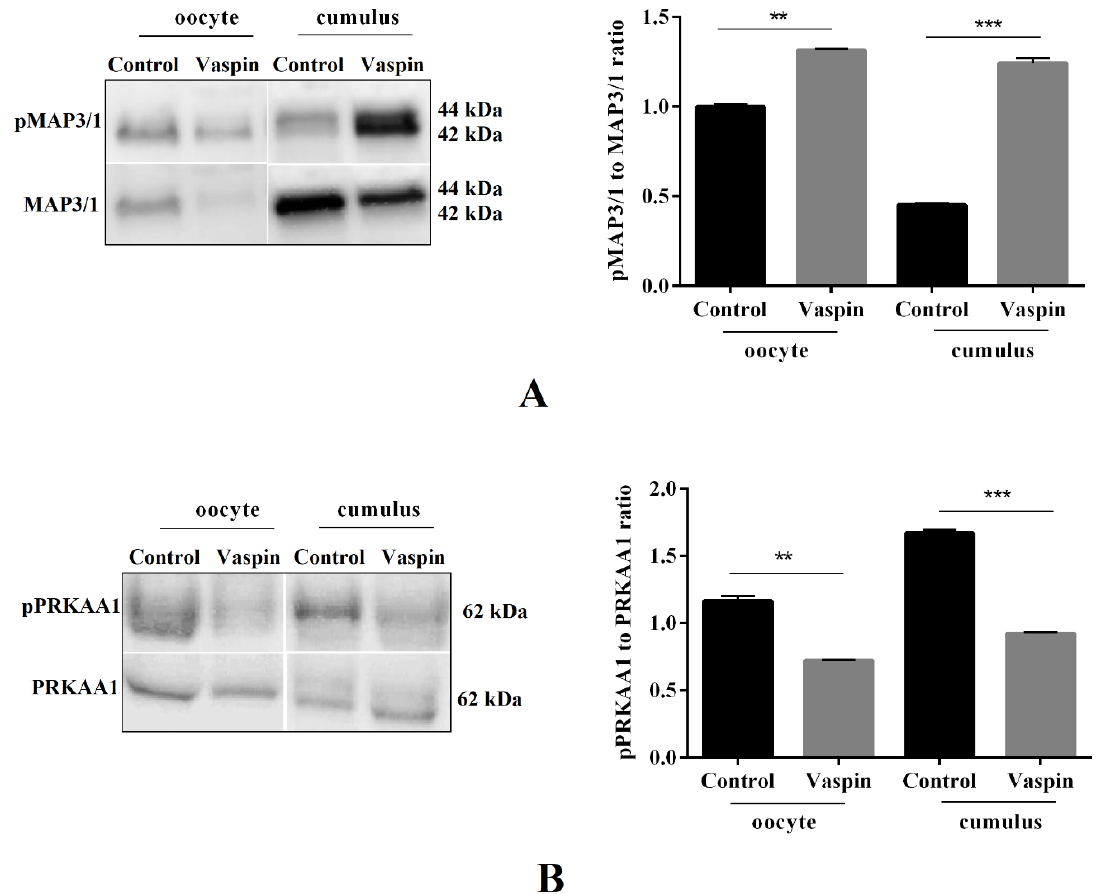
Figure 4. Effect of vaspin on mitogen-activated kinase (MAP3/1) and AMP-activated kinase (PRKAA1) phosphorylation in oocytes and cumulus cells after in vitro maturation. COCs phosphorylation in oocytes and cumulus cells after in vitro maturation. COCs (50 / group / experiment) (50/group/experiment) were selected after morphological examination of material collected from the were selected after morphological examination of material collected from the ovaries taken from 100 ovaries taken from 100 pigs (15 follicles/ovary). Porcine cumulus–oocyte complex (COCs) were pigs (15 follicles / ovary). Porcine cumulus–oocyte complex (COCs) were cultured for 44 h in maturation cultured for 44 h in maturation medium in the presence or absence of vaspin (1 ng/mL) then medium in the presence or absence of vaspin (1 ng / mL) then mechanically separated into oocytes mechanically separated into oocytes and cumulus cells. Phospho MAP3/1 (pMAP3/1), MAP3/1 ( A ) and cumulus cells. Phospho MAP3 / 1 (pMAP3 / 1), MAP3 / 1 ( A ) and phospho PRKAA1 (pPRKAA1), and phospho PRKAA1 (pPRKAA1), PRKAA1 ( B ) protein expressions were analysed by Western blot PRKAA1 ( B ) protein expressions were analysed by Western blot analysis. Protein expression levels analysis. Protein expression levels were normalised to actin. Experiments were performed were normalised to actin. Experiments were performed independently and repeated three times ( n = 3). independently and repeated three times ( n = 3). Data are plotted as the mean ± SEM of three Data are plotted as the mean ± SEM of three independent experiments. Significance between control independent experiments. Significance between control and vaspin is indicated by ** p < 0 . 01 and *** and vaspin is indicated by ** p < 0.01 and *** p < p < 0.001.